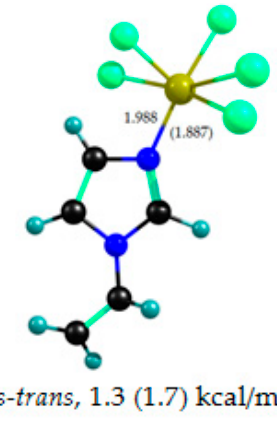
Figure 3. Predominant conformations of the complex of N -vinylimidazole with PCl 5 optimized by the B3LYP/6-311G** method, and their relative energies. Bond lengths are given in Å. The relative energies and bond lengths, calculated taking into account the solvent effect (nitromethane) within the PCM, are given in parentheses.